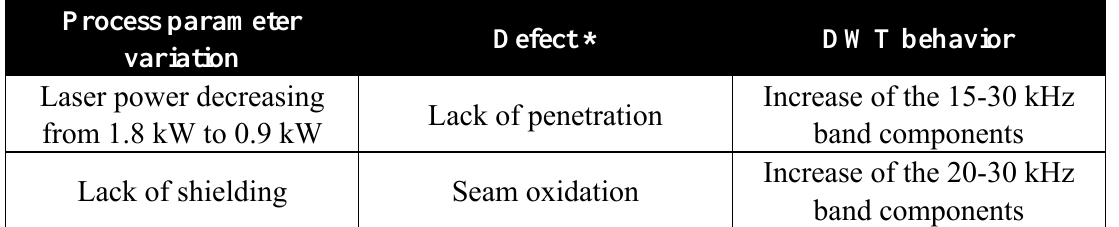
Table 2. DWT behavior as a function of the operating parameter and the detected defects (*induced defects have been recognized by metallographic or visual inspections of the welded